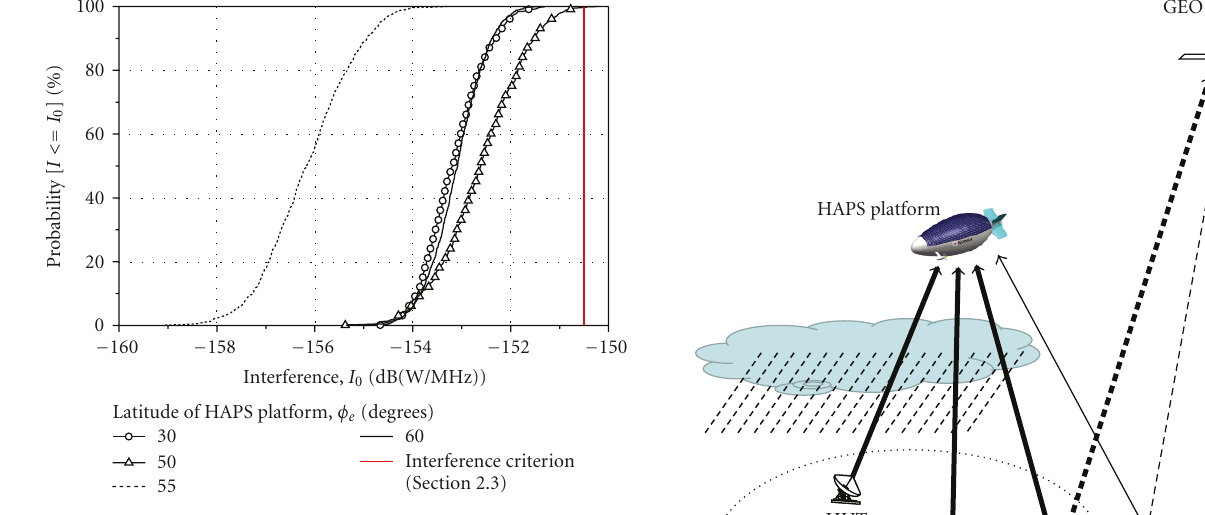
Figure 8: Interference level with the latitude of an HAPS platform φ e , using the FSPC scheme ( P R = 5dB).